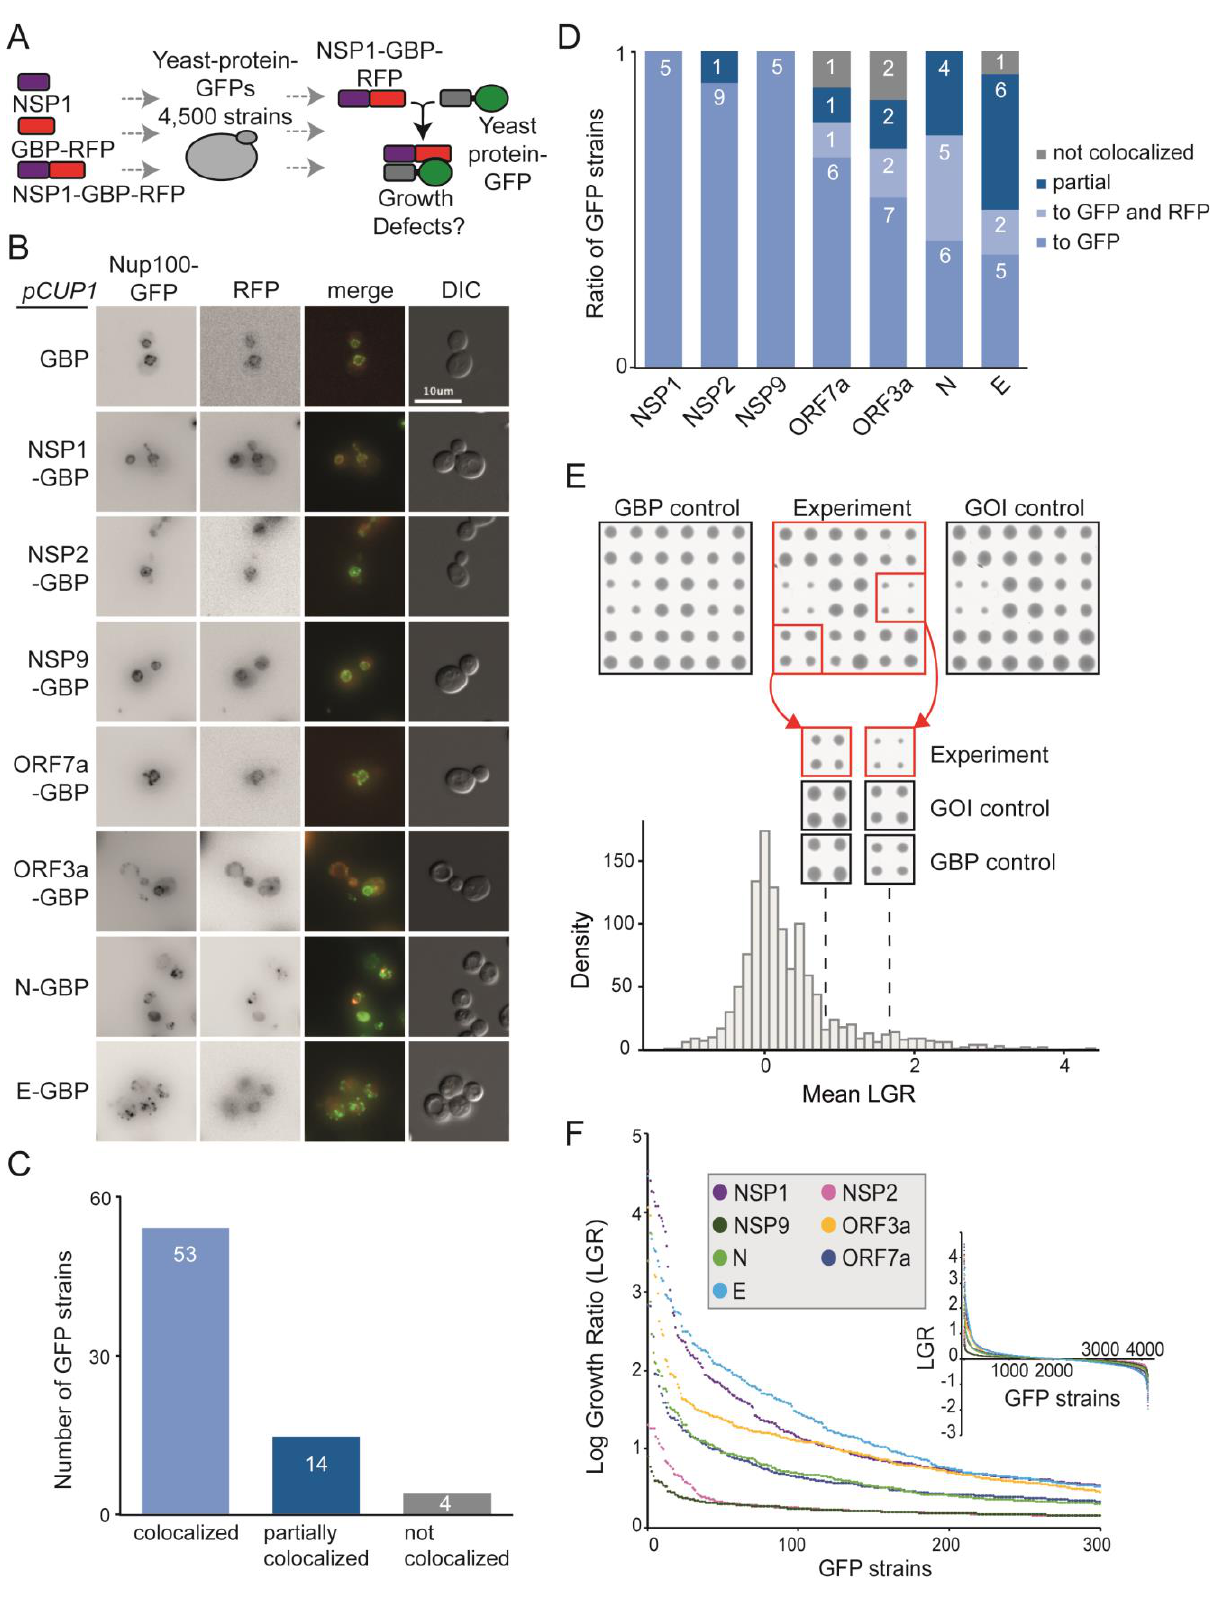
FIGURE 2: Forced binding of SARS-CoV-2-GBP-RFP fusion proteins to the yeast proteome. (A) The schematic illustrates the SPI screen, which involved recruiting SARS-CoV-2 proteins (tagged with GBP) to different GFP proteins, the viral protein alone and GBP alone serve as